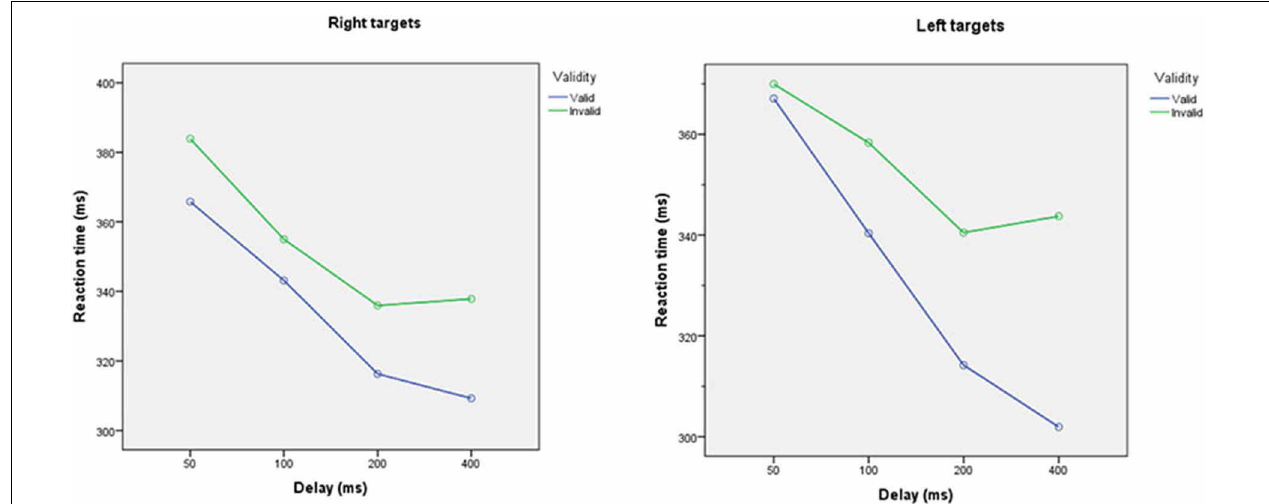
FIGURE 4 | Reaction times to validly and invalidly cued targets at different cue-target intervals for targets appearing on the left (left panel) and right (right panel), averaged across all participants.